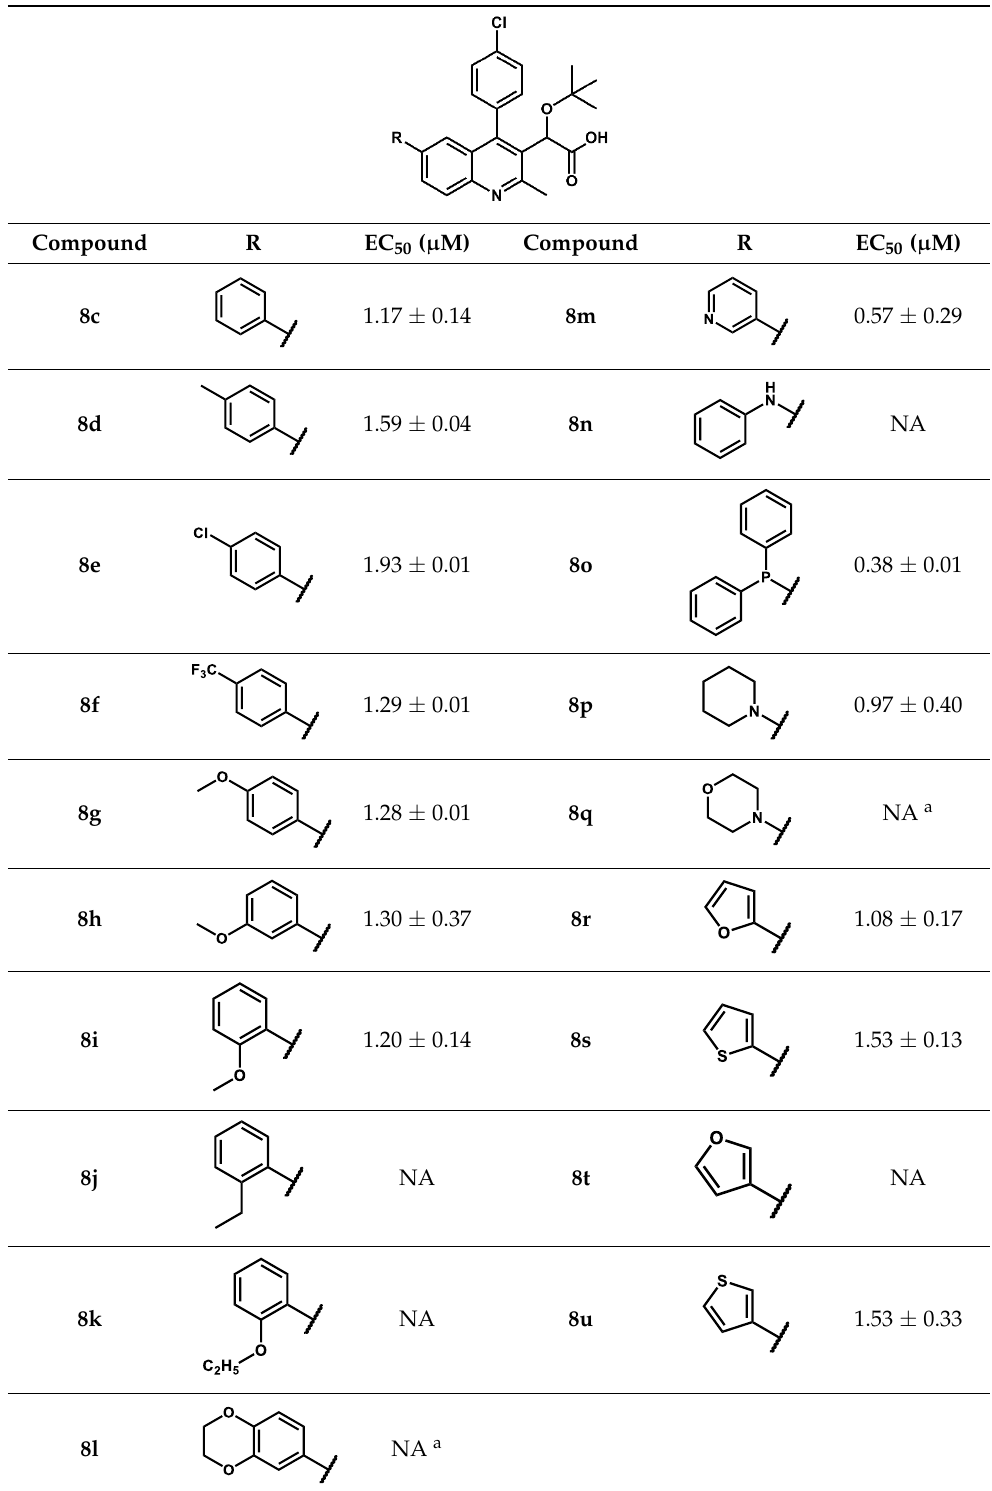
Compound Compound Compound